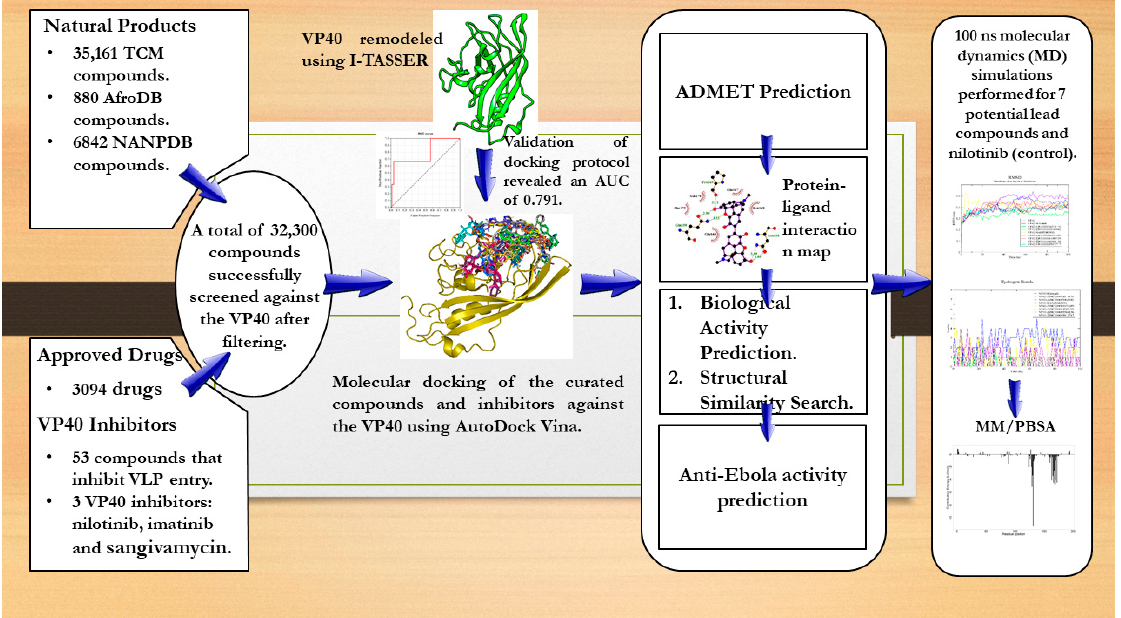
Figure 7. Schema of methodology detailing the step-by-step approach used to identify potential anti-VP40 compounds.